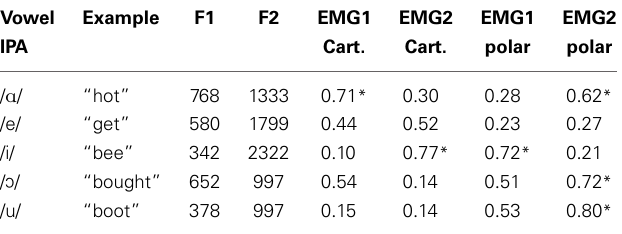
Table 2 | Average formant frequencies (Hz) for U.S. English vowels produced by 45 males (from Hillenbrand et al., 1995), with the corresponding EMG magnitude under Cartesian and polar transform.